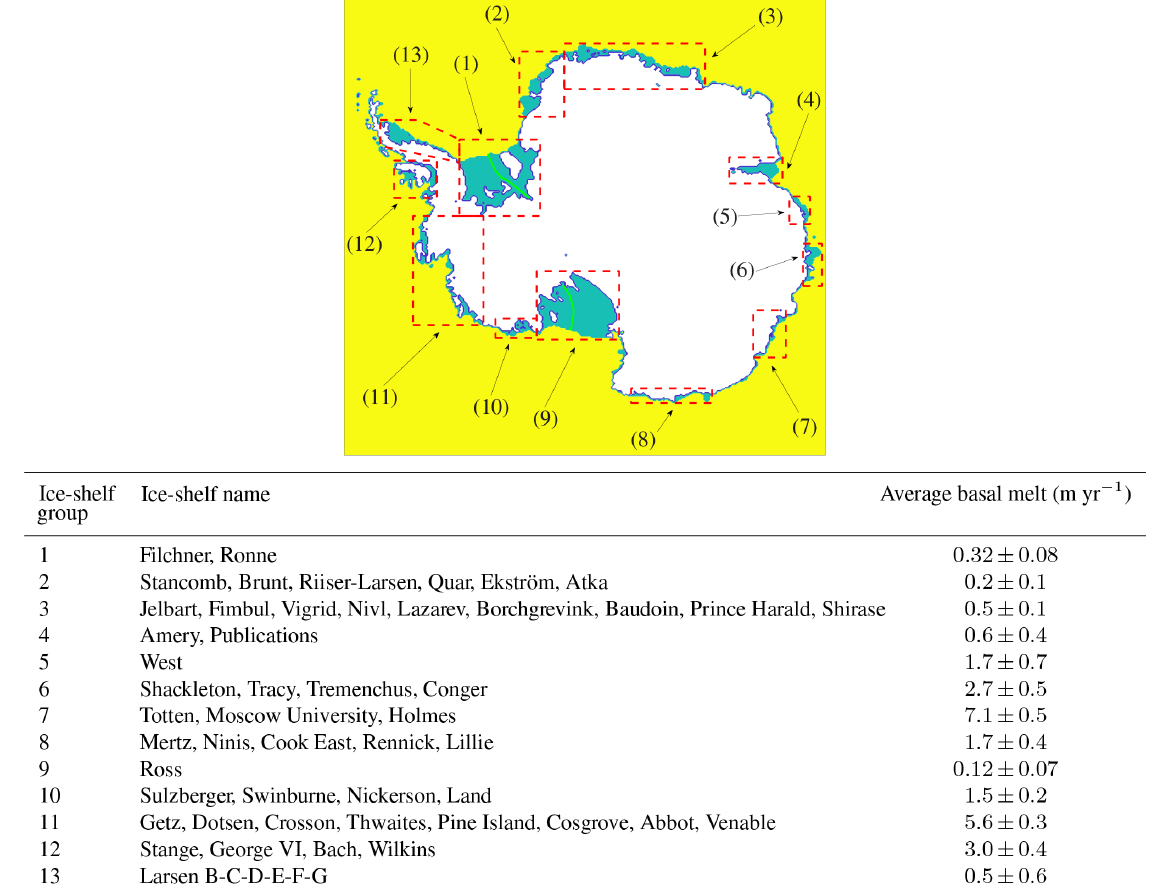
Figure 6. The 13 groups of ice shelves used for constructing the effective ocean temperature field. Average melt rates and error estimates (1SD – 1 standard deviation) for each group are calculated from the data of Rignot et al. (2013) for individual ice shelves. Green lines indicate the approximate positions of the flow lines used in Fig.